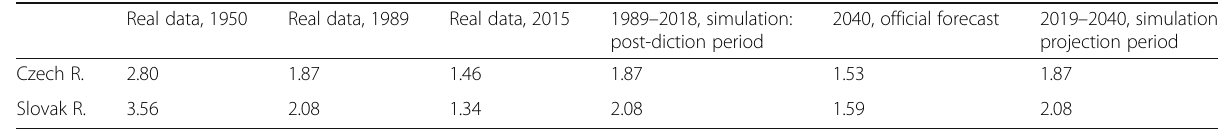
Table 1 Overview of values of the total fertility rate in selected years Real data, 1950